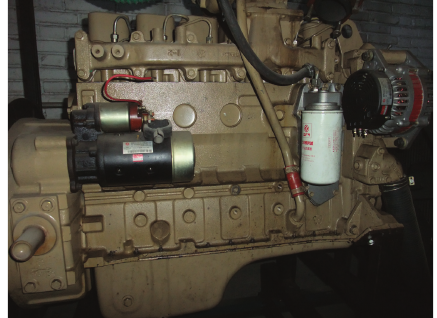
Figure 4: The experimental